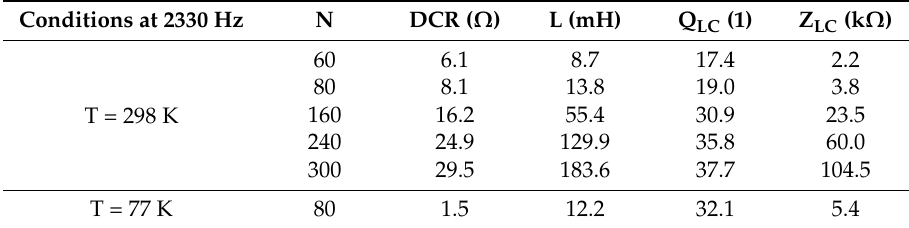
Table 1. Parameters of the 1 m square rigid